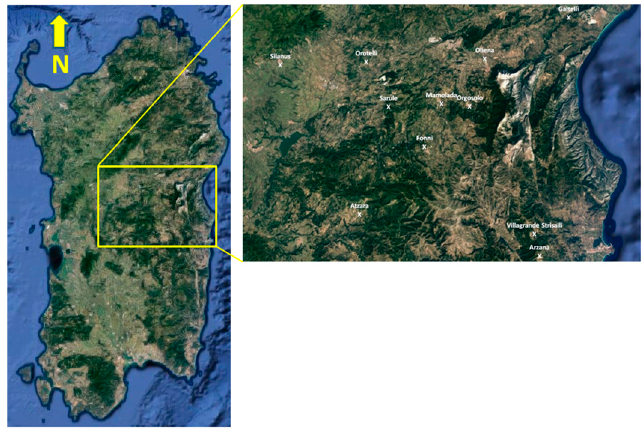
Figure 2. Geographical localization of the eleven towns of Central Sardinia where craft Filuferru samples considered in this study were produced.